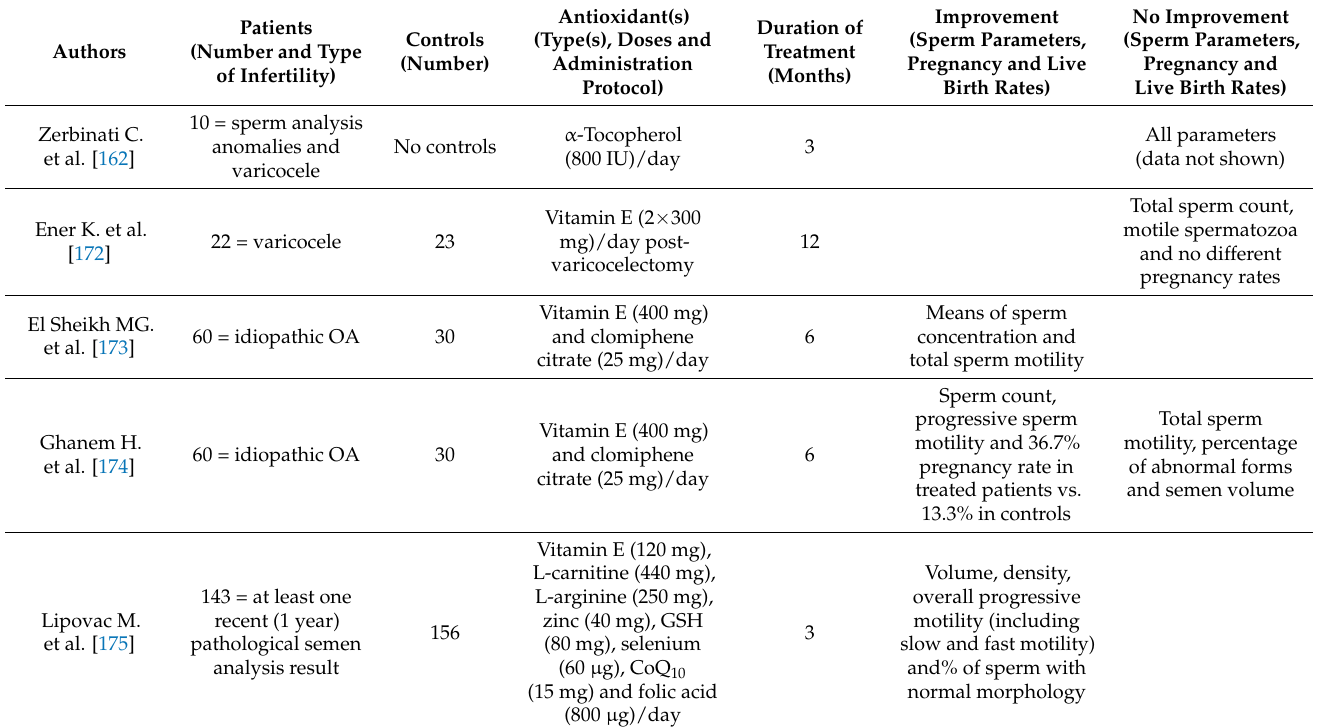
Table 3. Summary of the main results obtained in the 7 papers focusing on the effect of α -tocopherol administration for the treatment of male